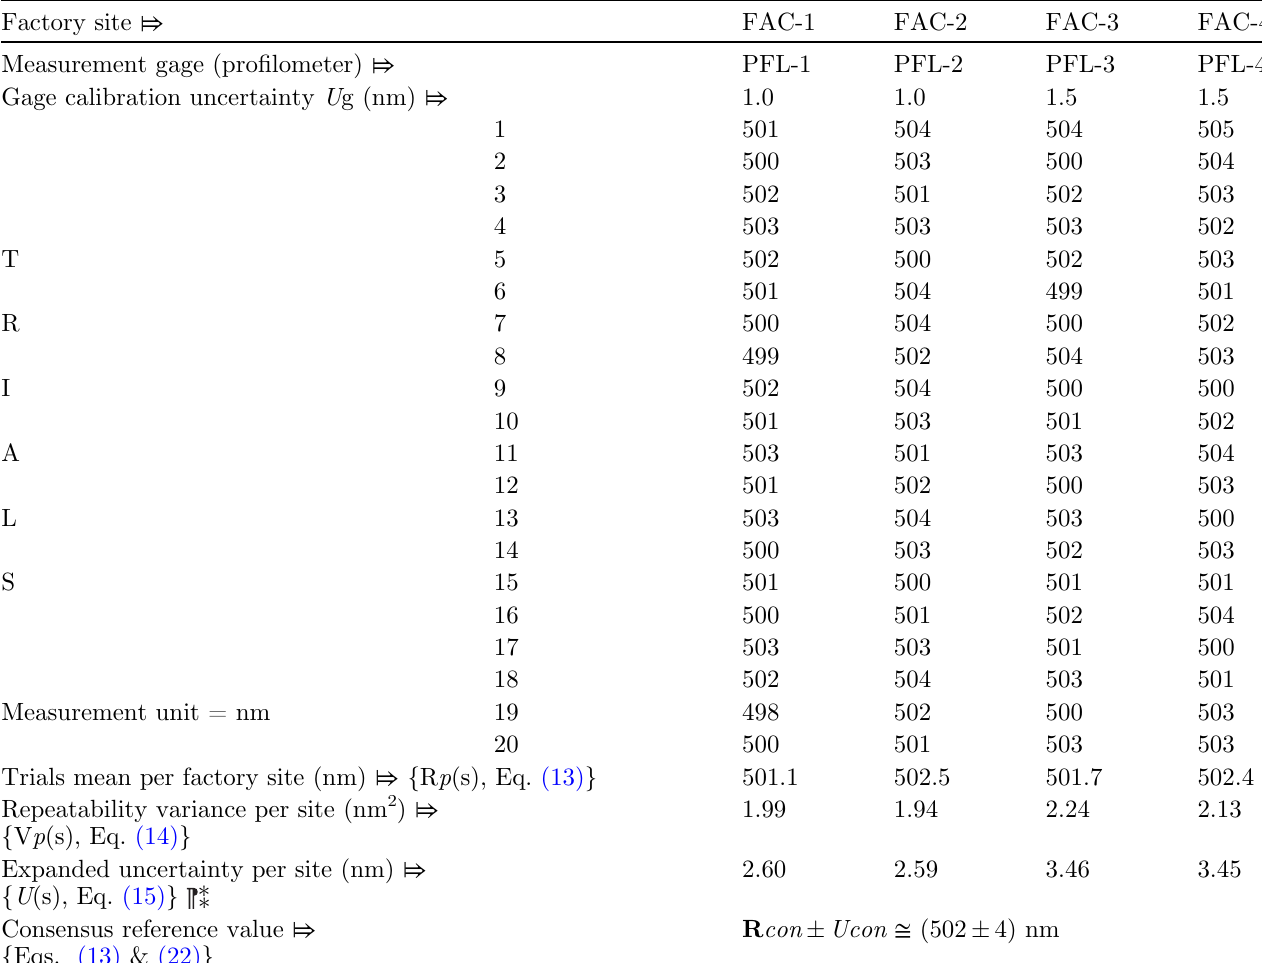
Table 2. Example 2. Consensus trials; k = 4 factories (FAC-1 – FAC-4). Factory site ∣